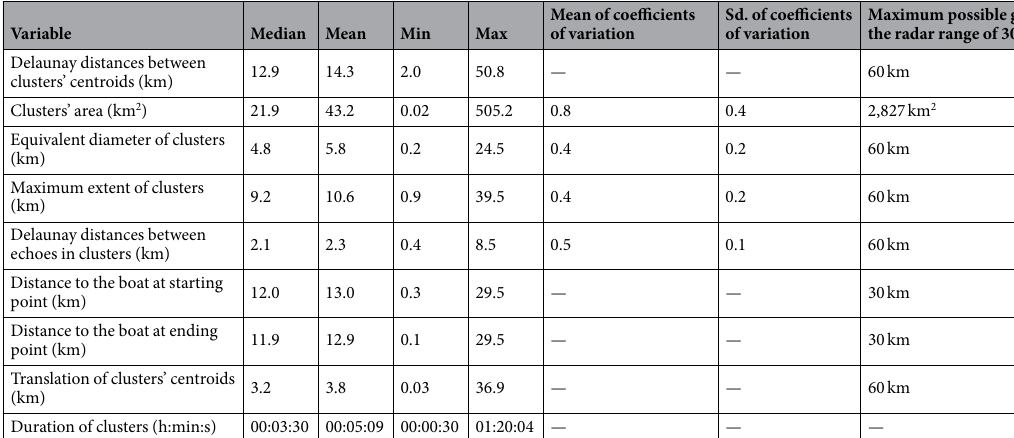
— — Table 1. Descriptive statistics of clusters. Delaunay distances between clusters’ centroids correspond to the length of edges obtained by Delaunay triangulation on synchronous clusters’ centroids. Clusters’ areas, equivalent diameters, maximum extents and Delaunay distances between echoes were averaged for each cluster during its lifetime. Coefficients of variation of the four previous metrics (along clusters’ tracks) were calculated for each cluster. The mean and standard deviation of all coefficients of variation are reported for the four metrics (columns 6 and 7). Distances to the boat at starting and ending points refer to the distance of clusters’ centroids to the boat at the beginning and at the end of clusters’ tracks. Translations of clusters correspond to the distance between their starting and ending centroids’